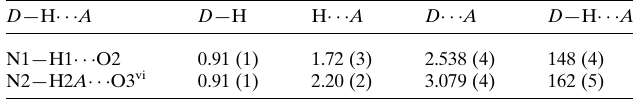
Table 1 Hydrogen-bond geometry (A˚ , (cid:2) ).